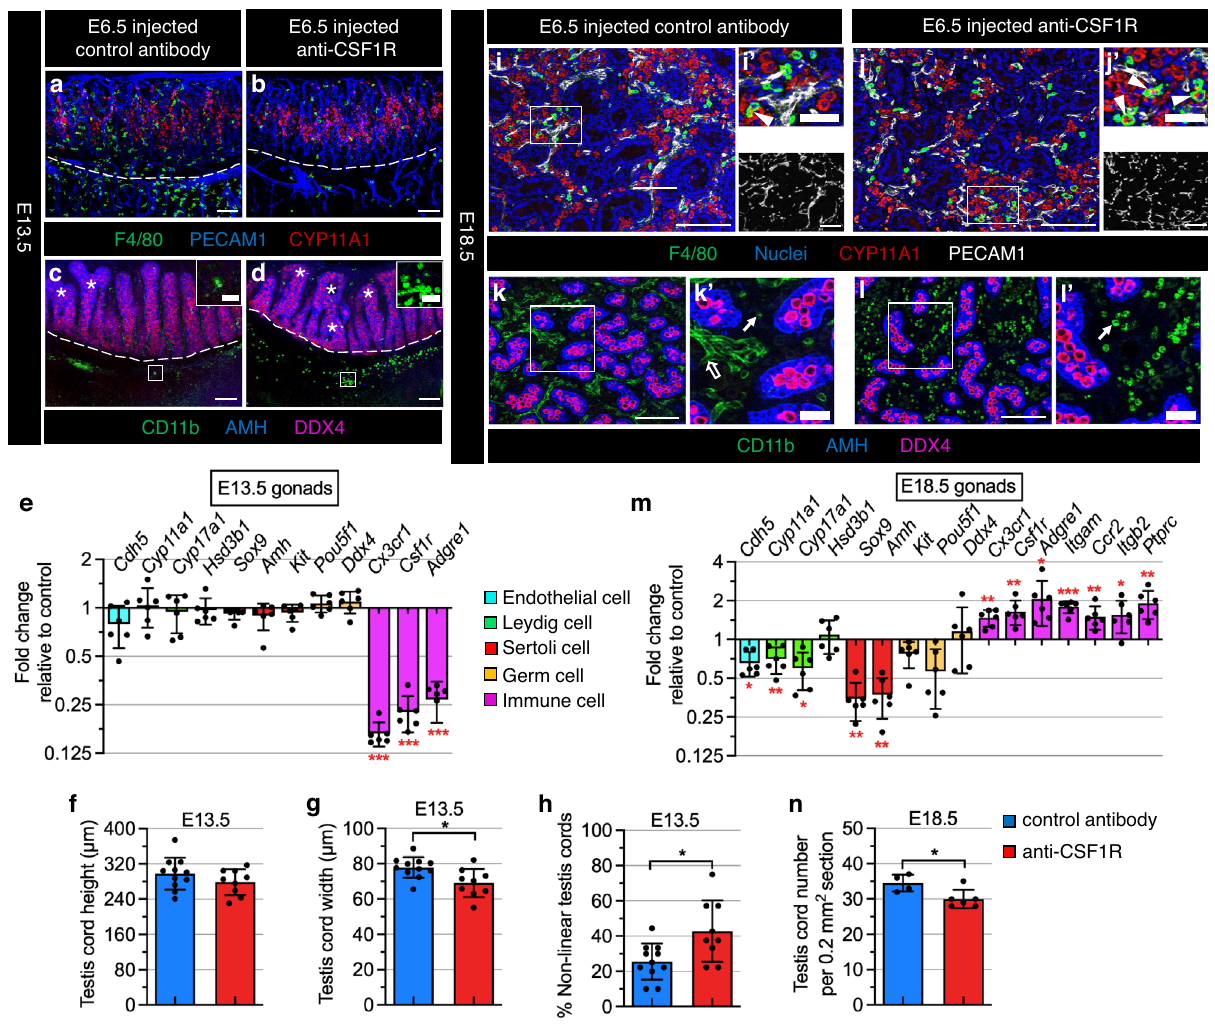
Fig. 6 | EMPs and HSC-derived macrophages have distinct functions during fetaltestisdevelopment.a – d ImagesofE13.5fetaltestesfromC57BL/6Jembryos exposed at E6.5 to either control rat IgG2a antibody ( a , c ) or anti-CSF1R blocking antibody to deplete YS-derived macrophages ( b , d ). Shown in ( a , b ) and ( c , d ) are representative images from n =4 and n =5 independent gonads, respectively. Dashed lines indicate gonad – mesonephros boundary. Asterisks denote fused or branched testis cords. Insets in c and d are higher-magni fi cation images of the boxed regions highlighting CD11b + cells (likely monocytes) in the gonad – mesonephrosborderregion.Thinscalebar,100 μ m;thickscalebarin c and d insets,25 μ m. e qRT-PCRanalysesofwholeE13.5fetaltestesshowingfoldchange of gene expression in YS-macrophage-depleted samples ( n =6 independent gonads) versus controls ( n =6 independent gonads). f – h Graphs showing quanti- fi cation of testis cordheight( f ),testiscordwidth( g ), and percent abnormal(fused and/or branched) testis cords ( h ) in E13.5 YS-macrophage-depleted samples ( n =11